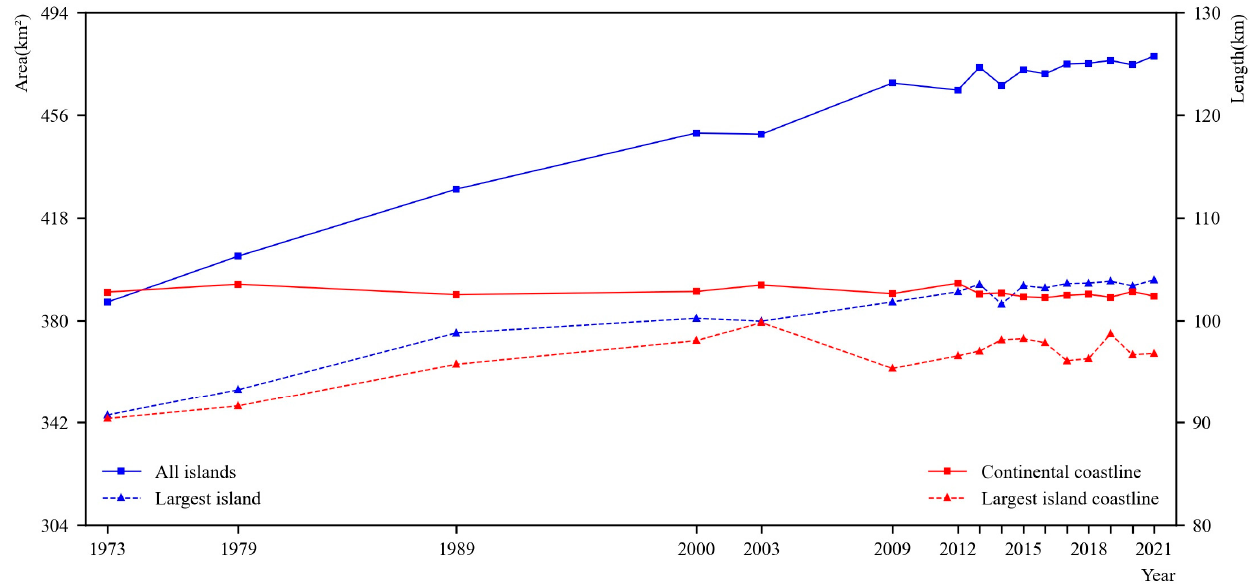
Figure 2. The length of coastlines and the area of islands. The blue solid line represents the total area of all islands, the blue dashed line represents the area of Bilu Island, the red solid line represents the length of the continental coastline, and the red dashed line represents the length of the Bilu Island coastline.